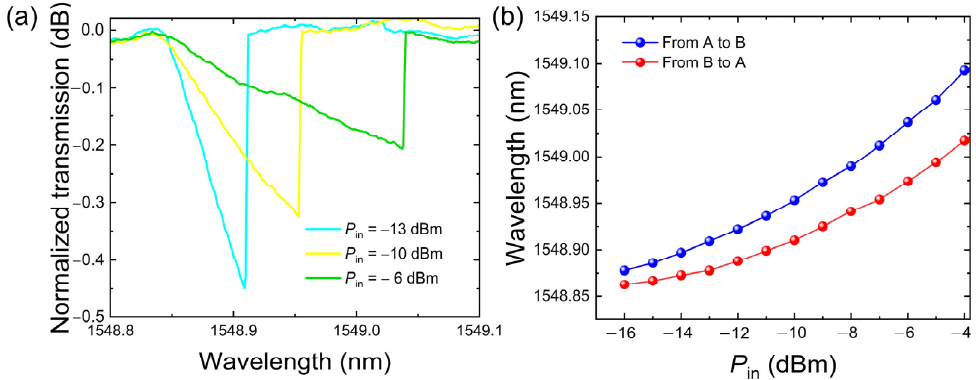
Figure 5. ( a ). Normalized optical transmission spectra swept from short to long wavelength under high input power P in from port A to port B with P in = − 13 dBm, − 10 dBm, and − 6 dBm, respectively. ( b ). Wavelength at bottom of transmission spectra versus input laser power with blue (red) points representing experimental data in case A (B) is input port.